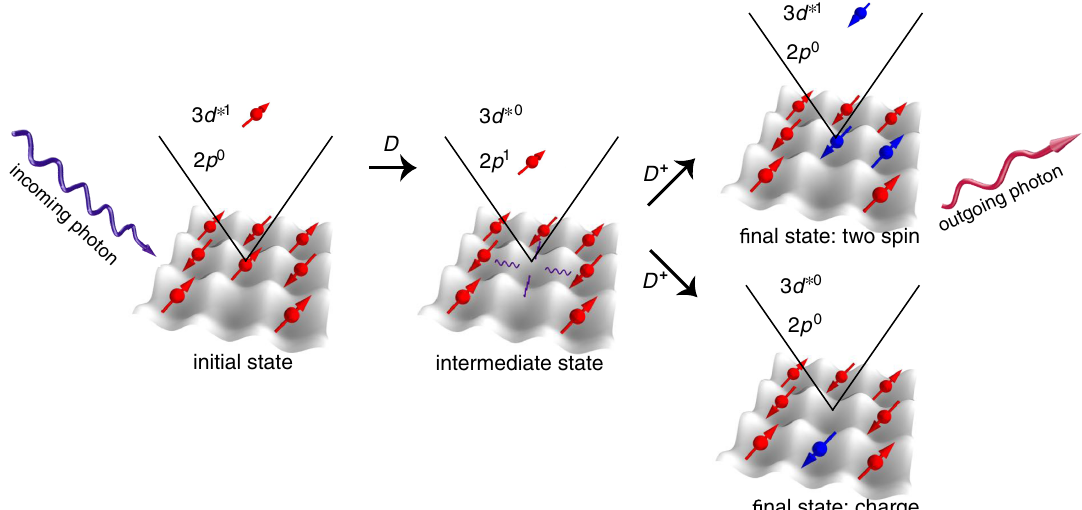
FIG. 10. A cartoon picture of the dominant Cu L -edge RIXS process in the parallel-polarized